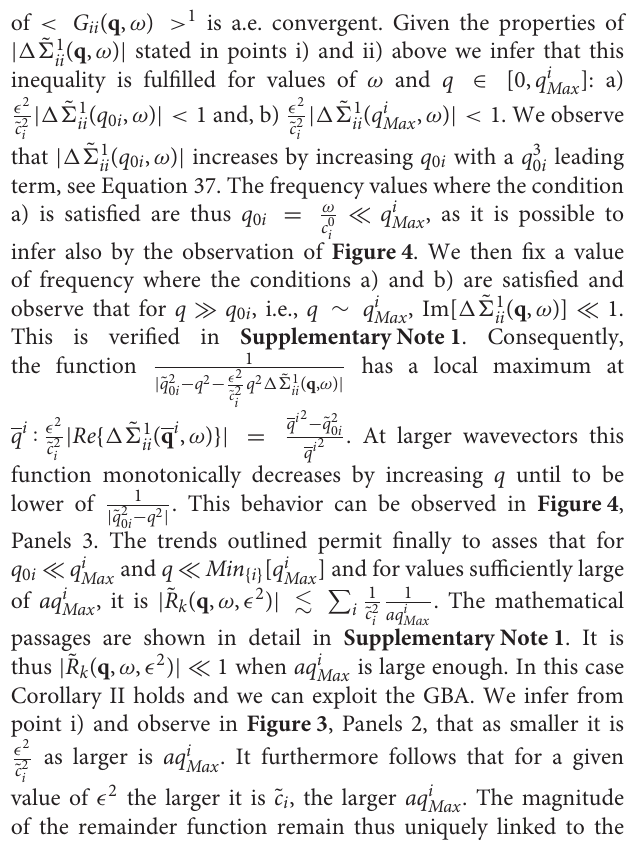
2 0 | 1 ˜ 6 1 L ( T ) ( q , ω ) | as a function of aq for three selected values of aq 0 L ( T ) . ˜ c 2 L ( T )